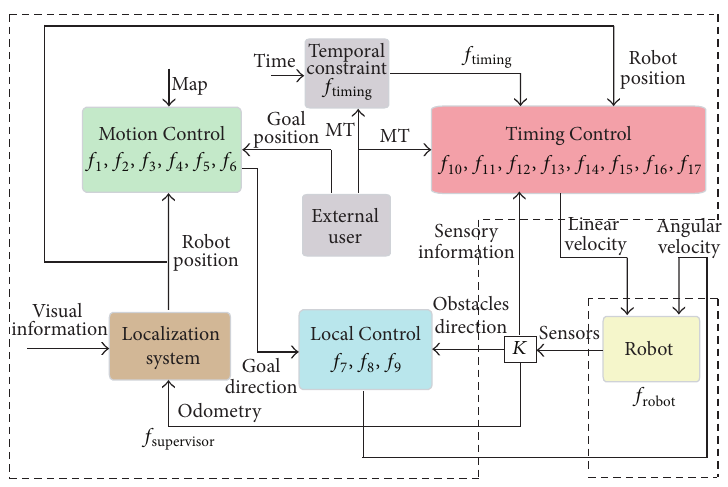
− 𝑓 − Environment (𝐾) mesh of systems that includes a detailed view of the Motion Control. Figure 2: View of the 𝑓 supervisor robot